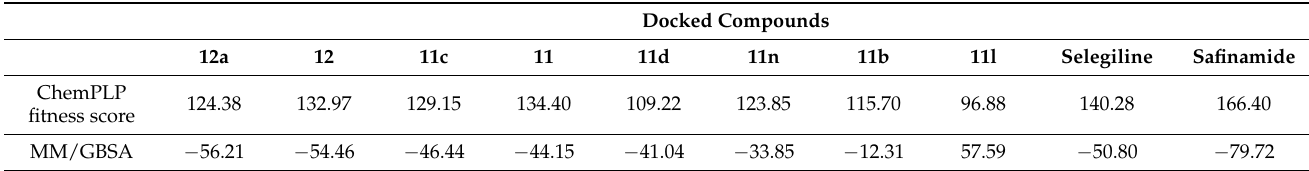
Table 1. GOLD 5.3 and MM/GBSA recalculations of pyrrole-based compounds in the crystallographic MAO-B structure (PDB ID: 1S3B).